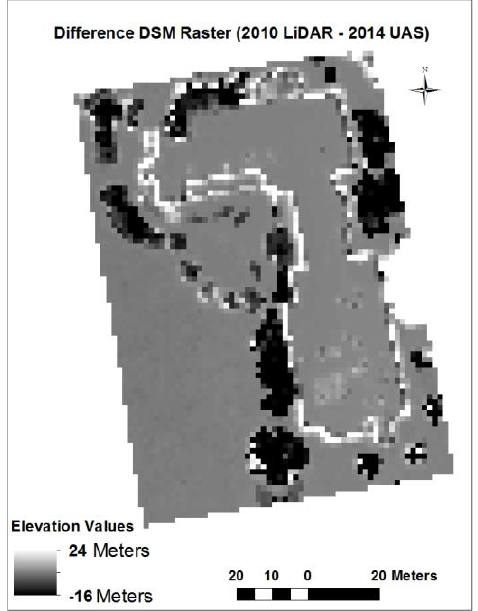
Figure 4. Difference in LiDAR and eBee DSM